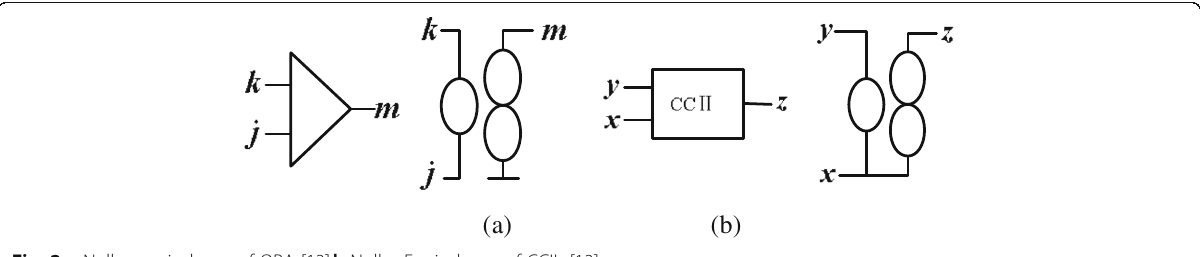
Fig. 2 a Nullor equivalence of OPA [13] . b Nullor Equivalence of CCII-